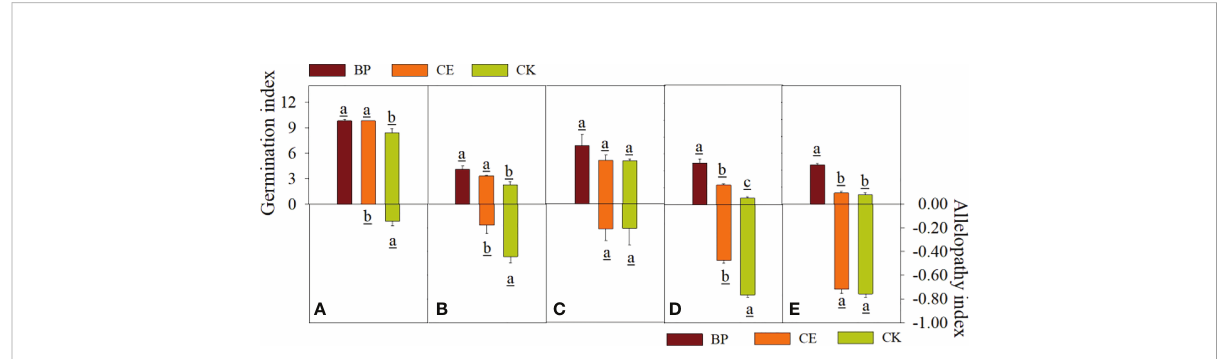
FIGURE 5 Effect of CE and CK root exudates on seed germination index in recipient plants. (A – E) shows the effects of CE and CK root exudates on seed germination index and allelopathic effect index of radish, cucumber, lettuce, pepper, and ryegrass